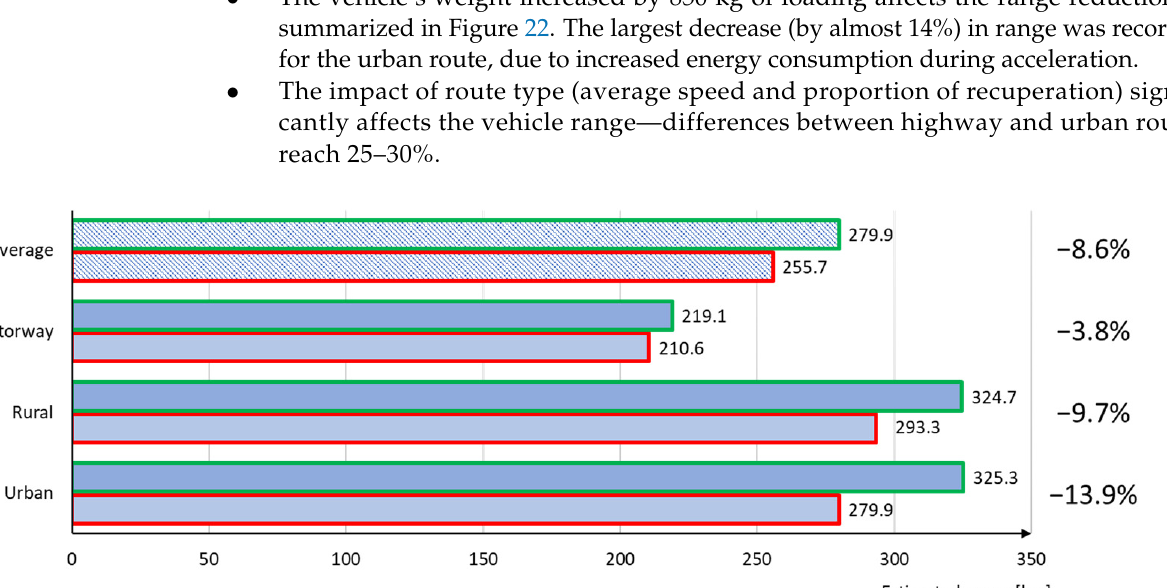
Figure 22. Effect of cargo weight on estimated range in different phases of the RDC test.